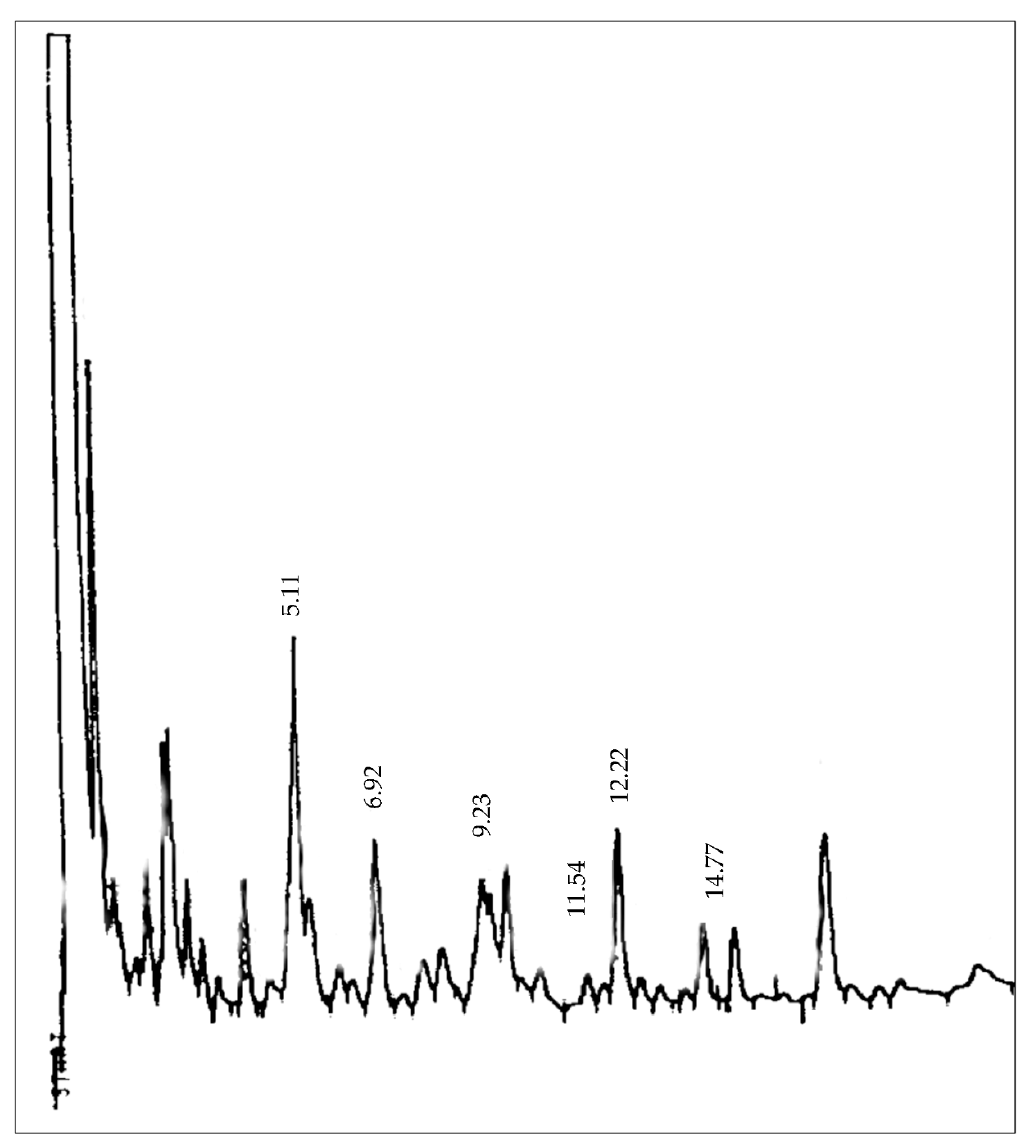
Figure 3. Chromatogram of phenolic compounds identified from Paldong cultivars.